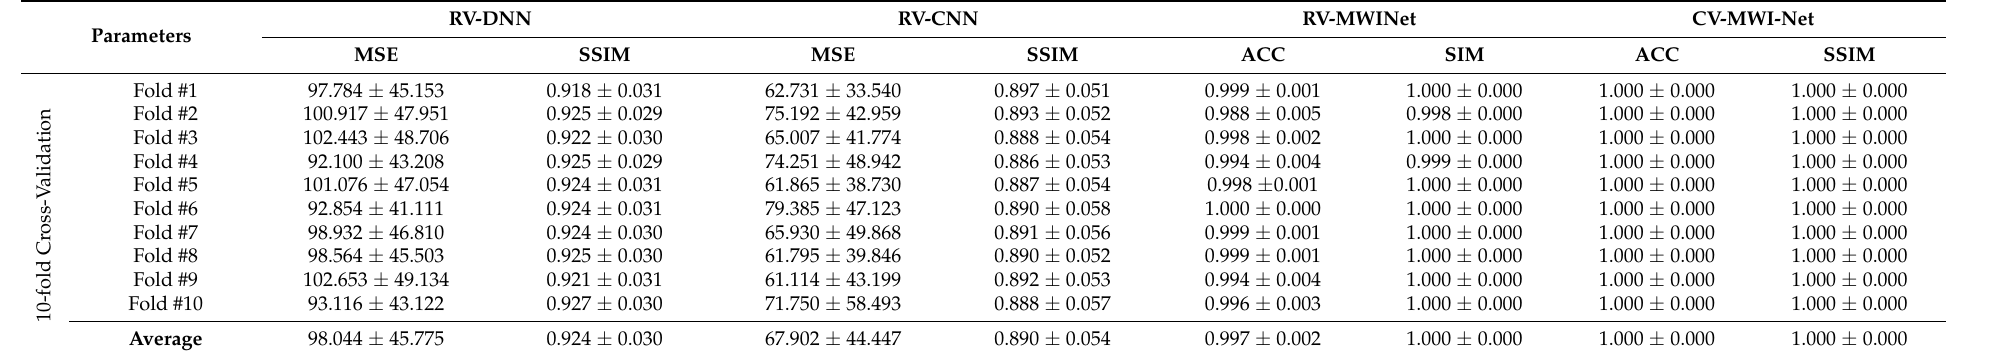
Table 3. Performance metrics of the proposed neurocomputational models for 10-fold cross-validation using train data.